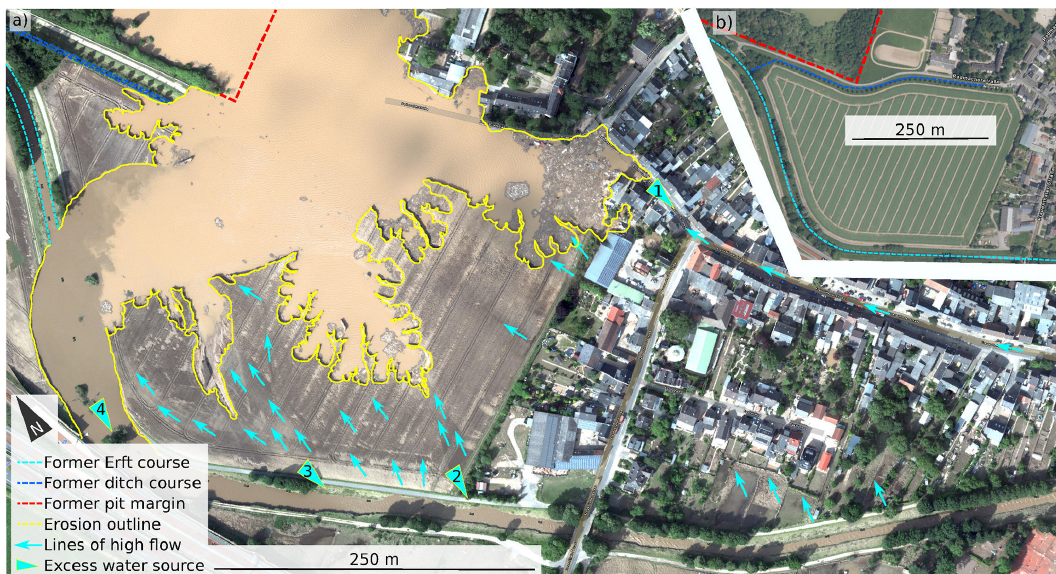
Figure 6. Aerial image (BBK-DLR, 2022) of the town of Blessem. (a) Situation shortly after the flood event, with annotated features. The top-right inset (b) shows conditions before the flood. The break in slope along the margin of a gravel pit (red dashed line) had started to erode towards the town by fluvial erosion (yellow line) that formed three individual clusters. The erosion was fuelled by overbank discharge of the Erft River, evading the town of Blessem and moving down the main street, as well as water flowing over the field west of the town margin, following the line of steepest descent. Water flow directions are indicated by blue arrows where visible from aerial imagery. The four numbered blue triangles depict sites of increased water input towards the